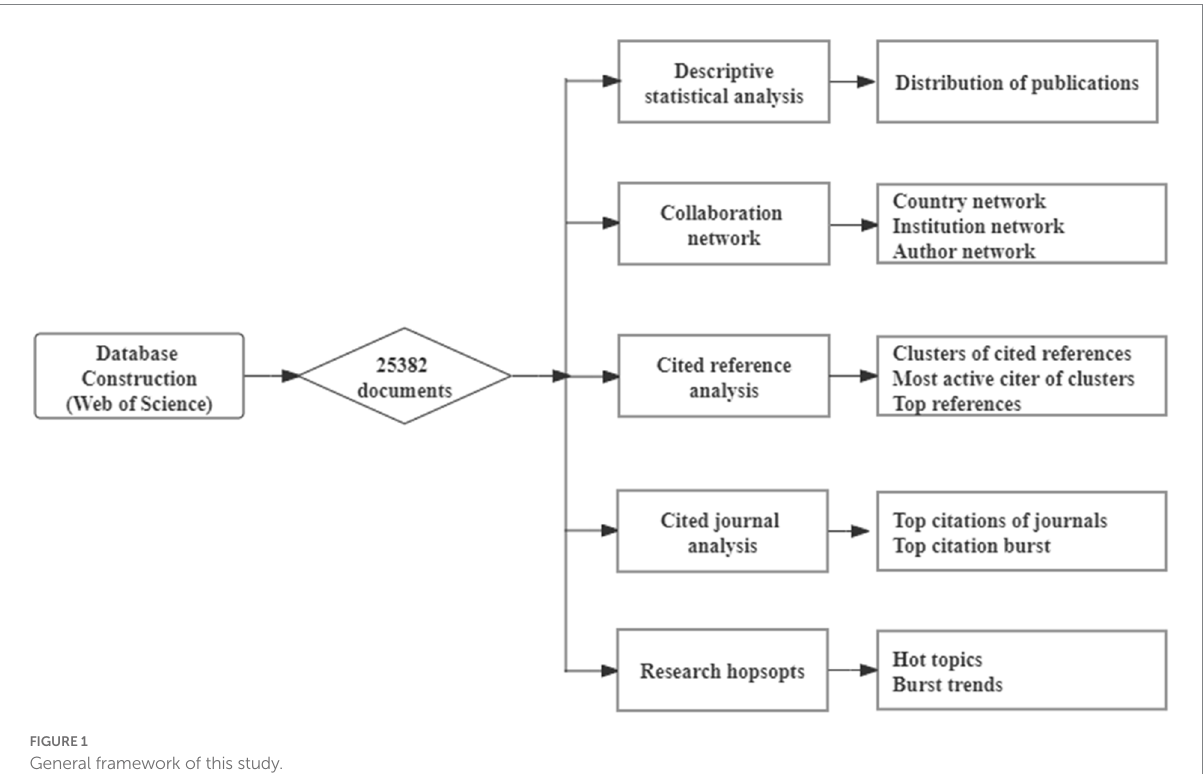
FIGURE 1 General framework of this study.